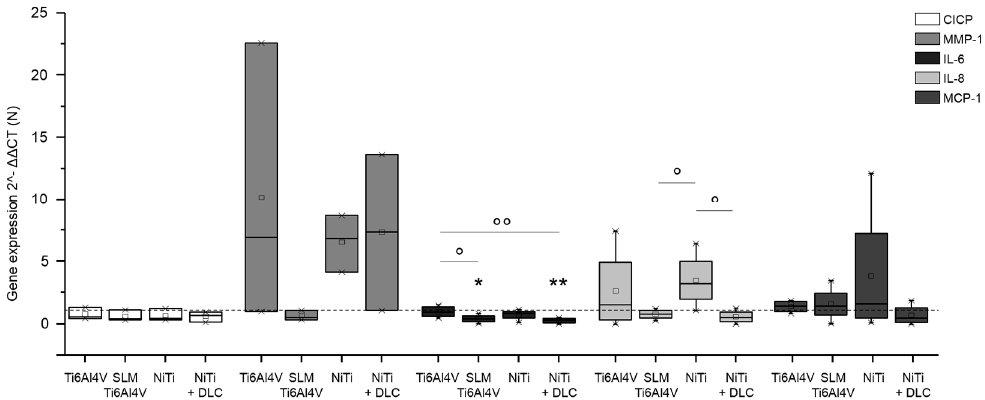
Figure 7. Gene expression (CICP, MMP-1, IL-6, IL-8, and MCP-1) of human fibroblasts ( n ≥ 3) after 96 h of cultivation on several test pellets (forged Ti6Al4V, Ti6Al4V SLM, NiTi, and NiTi + DLC). Boxes denote interquartile ranges, horizontal lines within the boxes denote medians, and whiskers denote minimum and maximum values. Data are normalized to the growth control (=100%, dotted line). For statistical analysis, ANOVA was conducted. A p -value < 0.05 was considered statistically significant. Comparison to growth control: * p < 0.05, ** p < 0.01. Comparison between several test pellets: ° p < 0.05, °° p < 0.01.